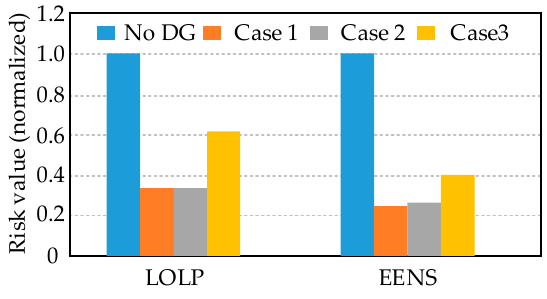
Figure 9. System risk under different DGs’ location.